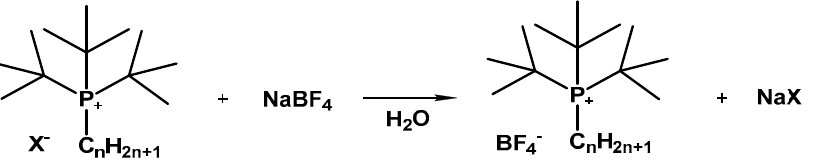
Scheme 2. The anion exchange reaction.